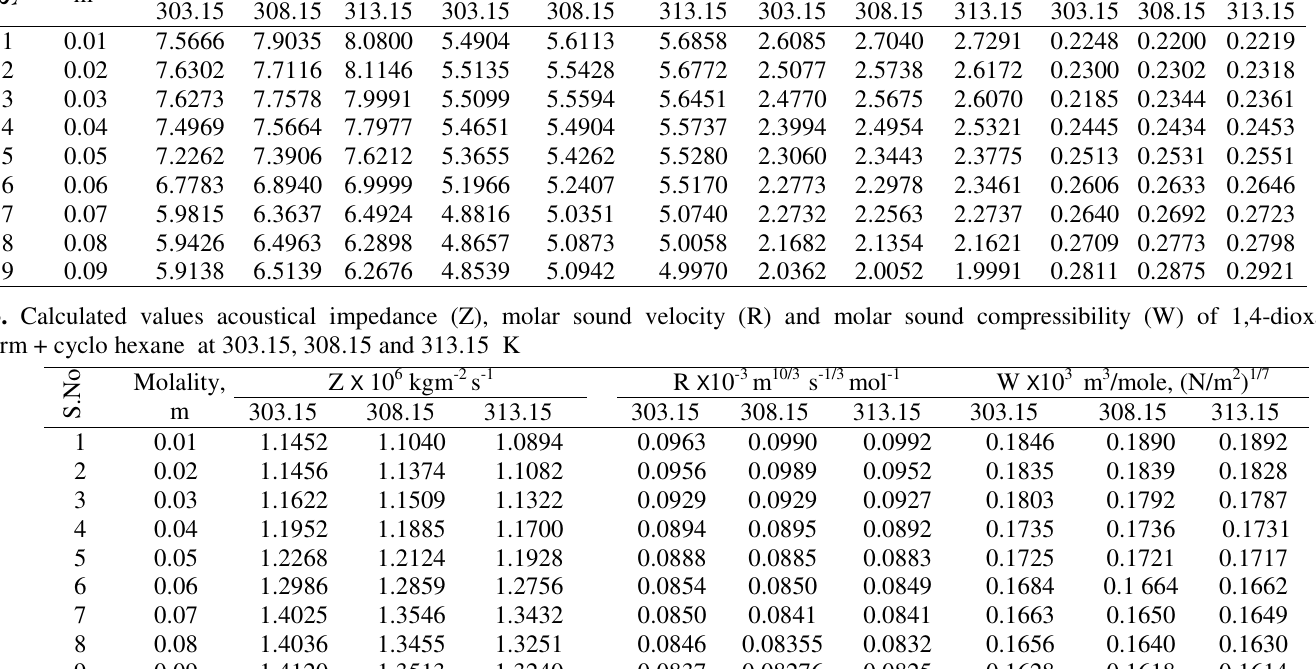
), free volume (V ) and internal pressure ( π ) of f f i